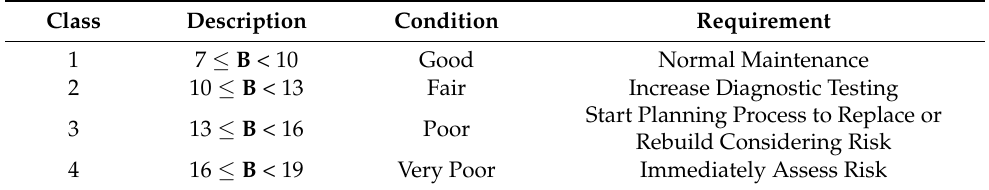
Table 2. Classification of transformers based on insulation conditions and range of B